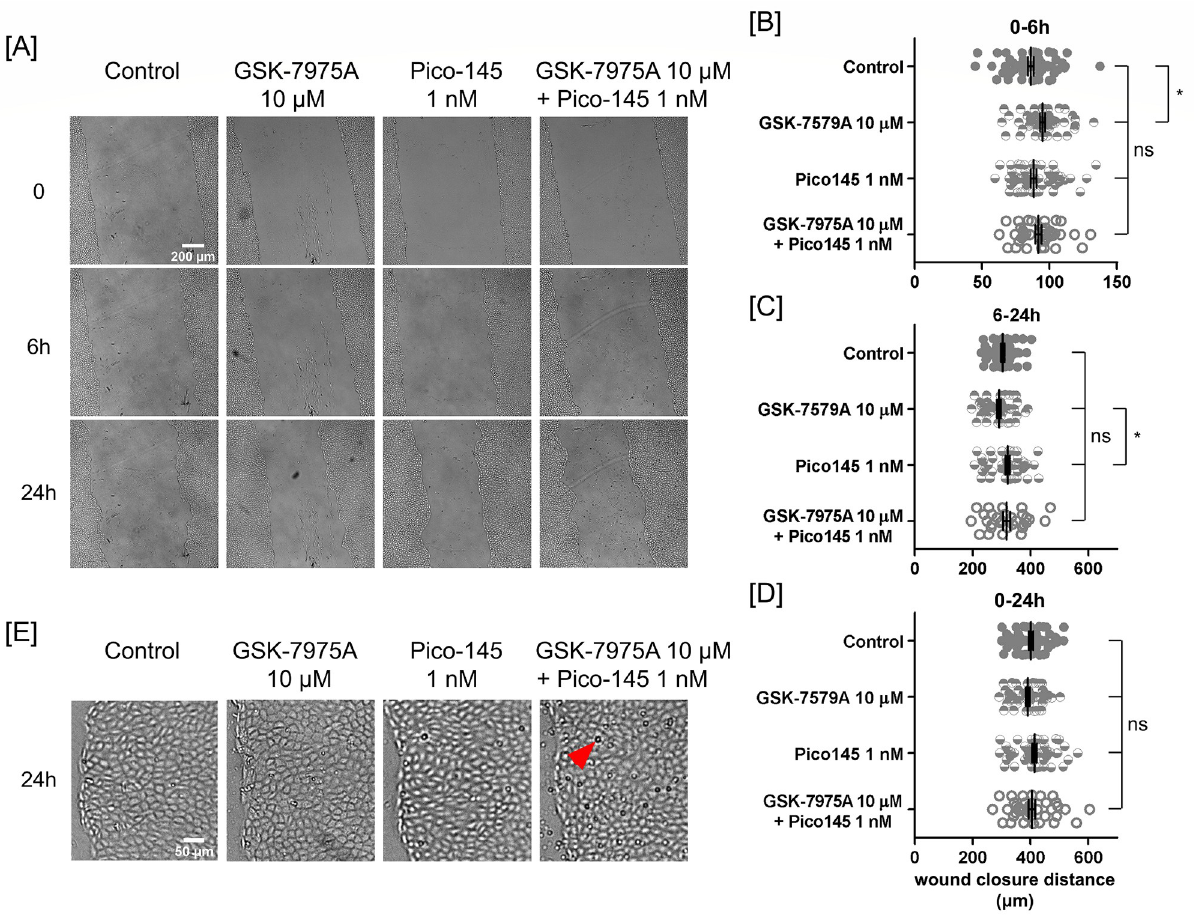
Fig 5. Inhibition of Orai1 and TRPC1/4 did not affect overall wound closure. (A) Brightfield images of scratched PAEC monolayers at 0, 6, and 24-hours in vehicle control, 10 μ M GSK-7975A, 1 nM Pico145, and combined 10 μ M GSK-7975A and 1 nM Pico145 conditions. Combined GSK- 7975A and Pico145 treatment caused an accumulation of floating particles over 24 hours. Studies were all conducted in Na + -containing migration media. Scatter plots of wound closure distance in (B) 0–6, (C) 6–24, and (D) 0–24 hours. Data were reported as mean ± SEM. (E) Magnified view of the marginal regions of the control, GSK-7975A-treated, Pico145-treated, and both GSK-7975A- and Pico145-treated cells after 24 hours of wound closure. An arrowhead points to a floating particle. Statistical significance was assessed using one-way ANOVA with Bonferroni post hoc test (ns—not significant, � —P <